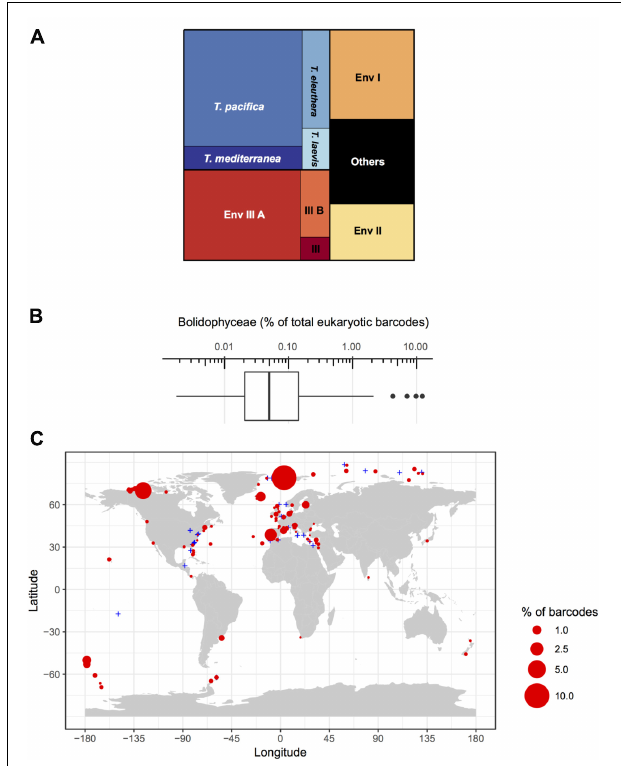
FIGURE 6 | (A) Distribution of read abundance among the different environmental Bolidophyceae clades and Triparma species in the metabarcoding studies based on the 18S rRNA V4 region listed in Table 2 . (B) Overall statistics of the proportion of Bolidophyceae reads related to the total number of reads from studies listed in Table 2 . Only surface samples were considered. (C) Oceanic distribution of Bolidophyceae. Circle size is proportional to the number of Bolidophyceae reads related to the total number of reads at a given